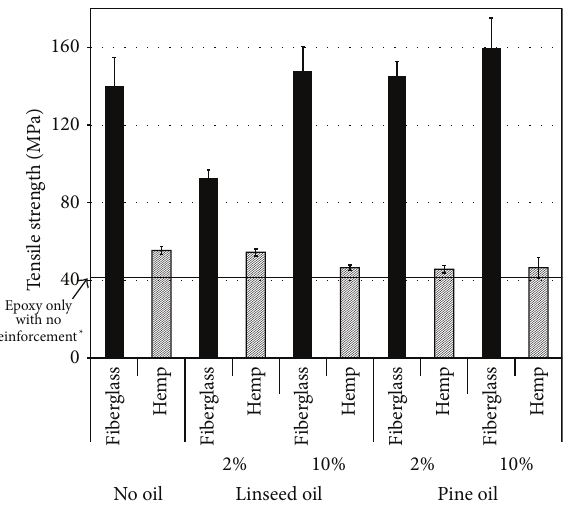
Figure 2: Modulus of elasticity for epoxy composites with and withoutoiladdition. ∗ DatatakenfromTAPPlasticsproductbulletin